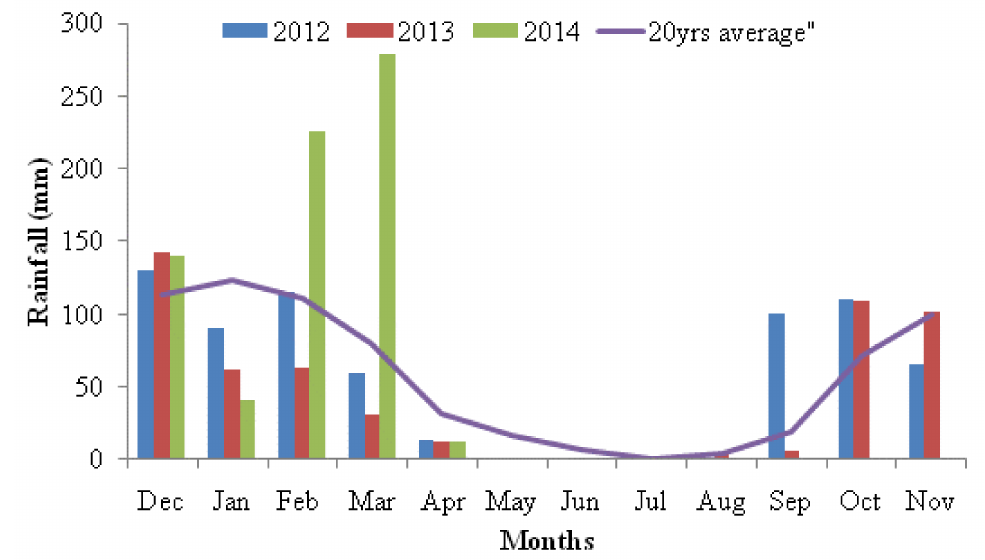
Figure 1. Monthly and 20 years long-term average rainfall data on the study area.